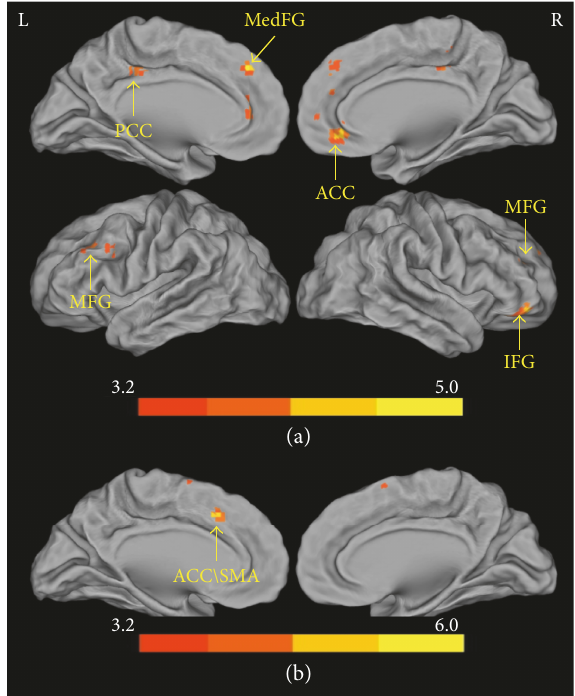
Figure 1: Brain mapping of intrinsic activity demonstrates a signi fi cant association with trait urgency ( P FWE = 0 05 , family-wise error correction). (a) The brain regions indicate correlations with mean scores of negative and positive urgency. (b) The brain regions indicate stronger correlations with negative urgency than with positive urgency. PCC: posterior cingulate cortex; MedFG: medial frontal gyrus; ACC: anterior cingulate cortex; MFG: middle frontal gyrus; IFG: inferior frontal gyrus; SMA: supplementary motor area.